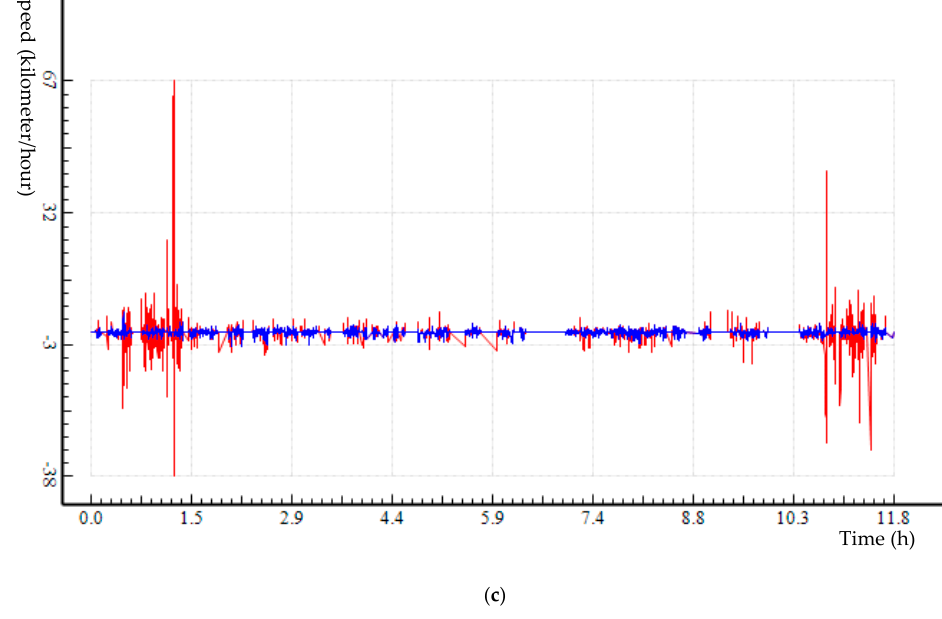
Figure A2. Speed loss in the post-simplification data using DP and EDP algorithms with a distance threshold of: 0.1-m ( a ); 1-m ( b ); and 10-m ( c ).